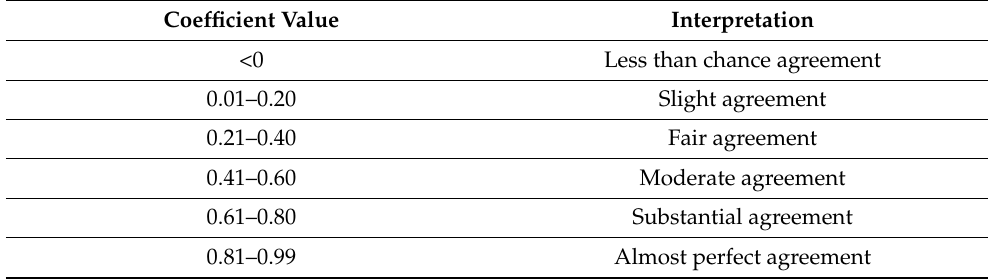
Table 3. Interpretation of intraclass correlation coefficients by Fleiss